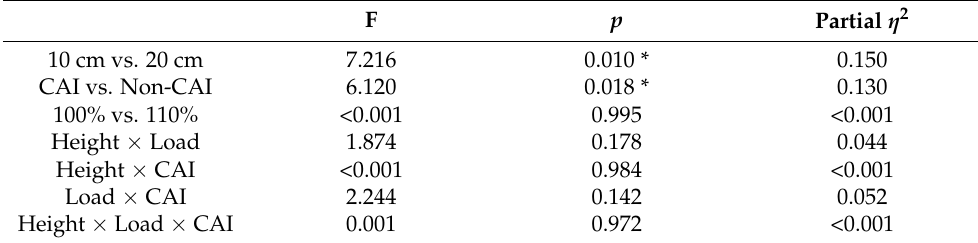
Table 2. A repeated measures ANOVA of the average AUC scores for landing height and group. F p Partial η 2 10 cm vs. 20